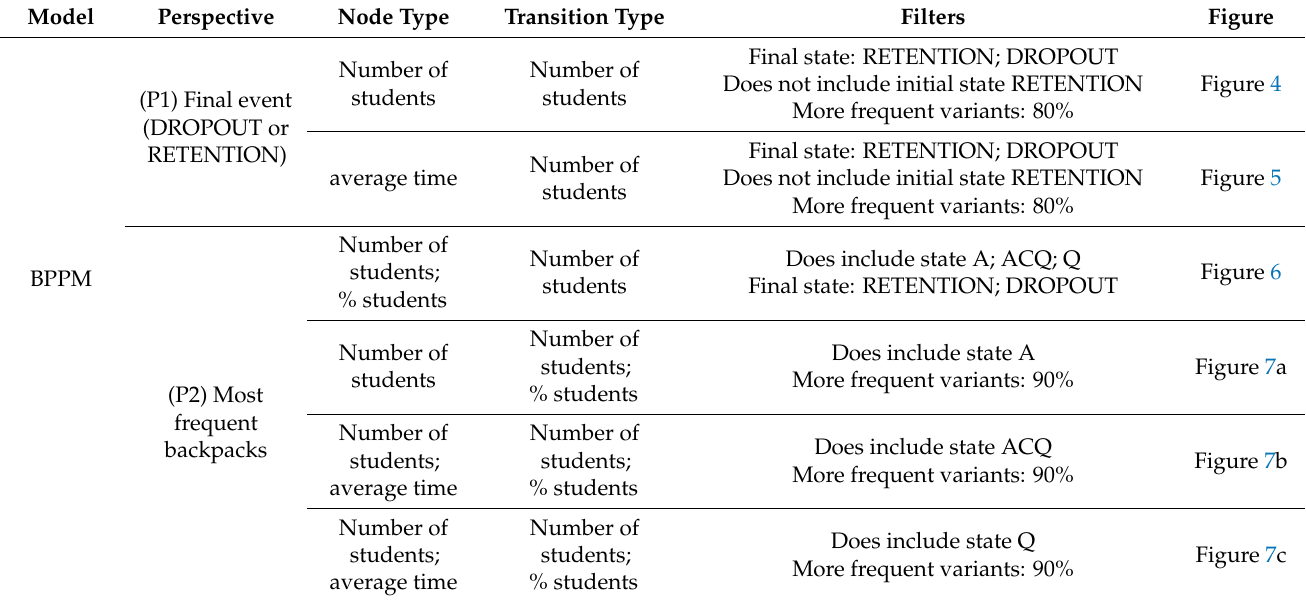
Table 3. Filters and properties applied to the event logs to perform each